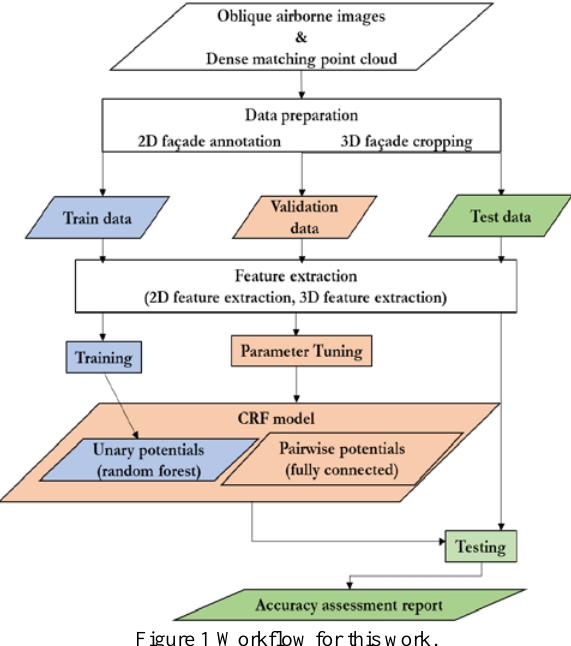
Figure 1 Workflow for this